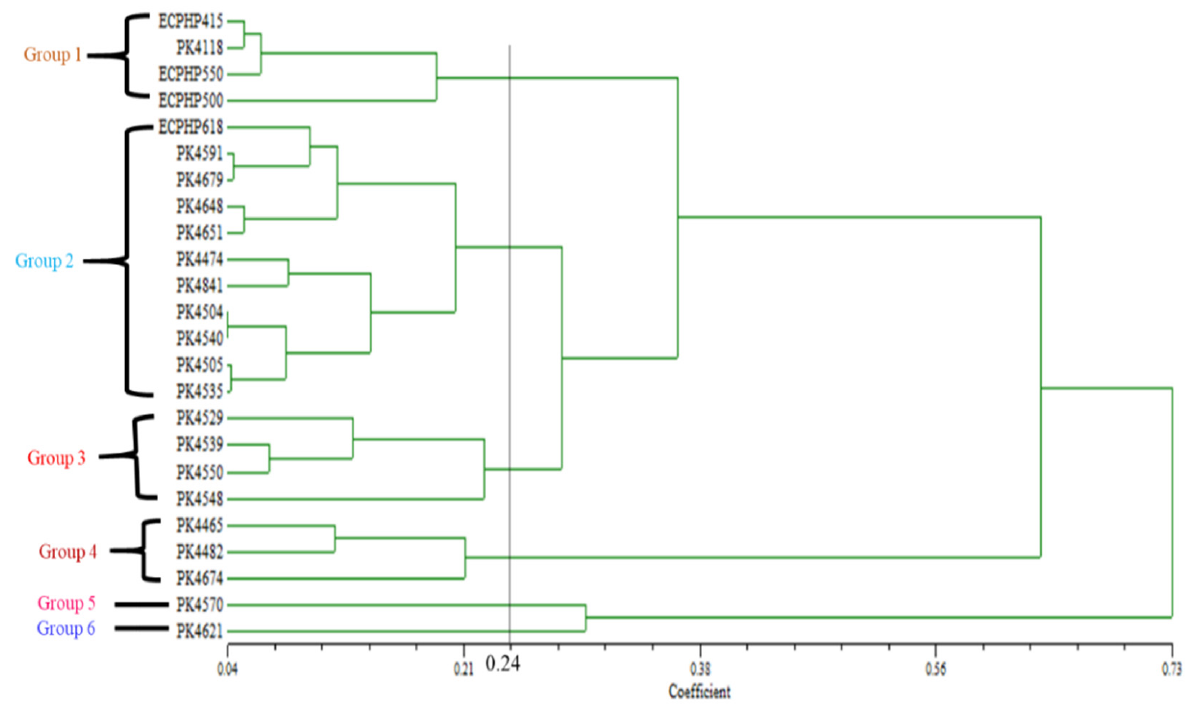
Figure 6. Dendrogram showing relationship of UPGMA clusters for 24 D × P biparental progenies based on their quantitative traits: ECPHP, Elaeis guineensis crossing program Hulu Paka; PK, Porim Kluang. Table 6. Means of cluster assembly and their quantitative characters for parents and their